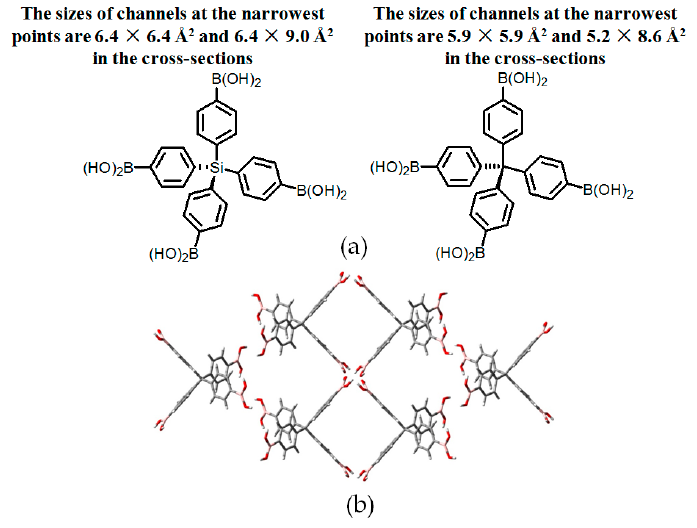
Figure 5. ( a ) Structures of building motif 3 (left) and 4 (right); ( b ) Top view of crystal network of H4 .